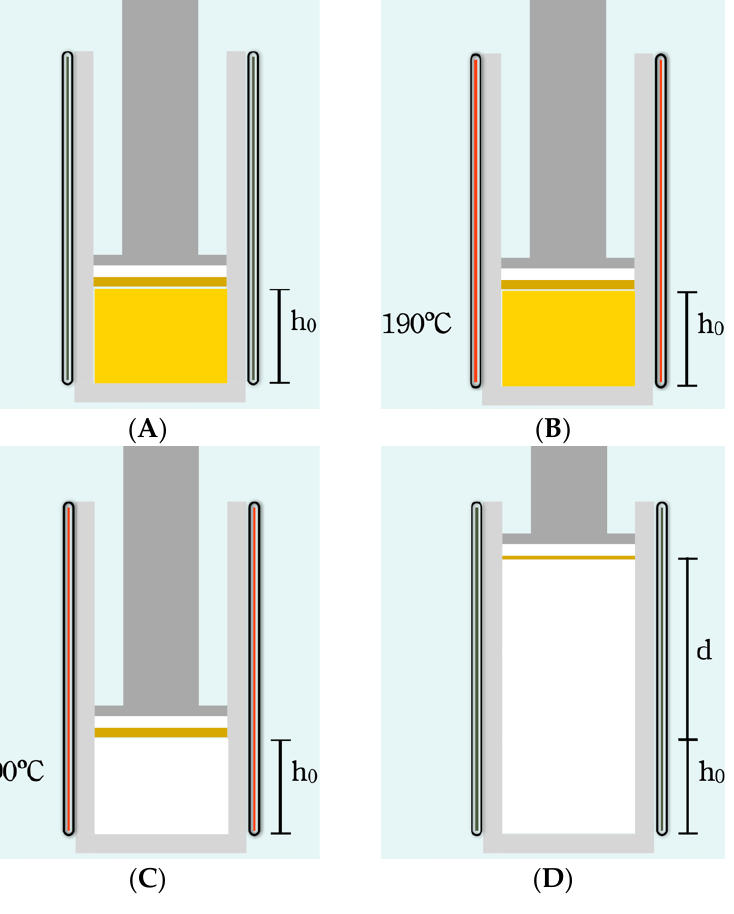
Figure 2. Making the foam from the precursor. ( A ) The foam was made in the same mold; we use a tight piston that does not allow the gas to escape. We seal it with 5 Tn. ( B ) Heat it to 190 ◦ C to decompose the AZO. The hydraulic press increases the load when the gas is released, up to 18 Tn for the lower-density foams 250 Kg/m 3 , up to 30 Tn for the higher-density foams 750 Kg/m 3 . For this reason, we could not make all the compositions for the higher-density foam, but only the 750 b (5.8% AZO) and 750 c (10.5% AZO). The other compositions break the seal. ( C ) When the pressure reaches the maximum, the entire AZO is decomposed; we turn off the heater and let the piston go up. ( D ) The increase in volume forms all the bubbles in the polymer. We cool the steel mold with water spray and squeeze the air for 5 min. Some of the foams broke when we removed the foam from the mold because there were still large amounts of gas in the core of the foam.